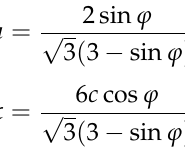
Figure 3. The cross-section of the piled wharf structure. Table 1. Materials parameters.